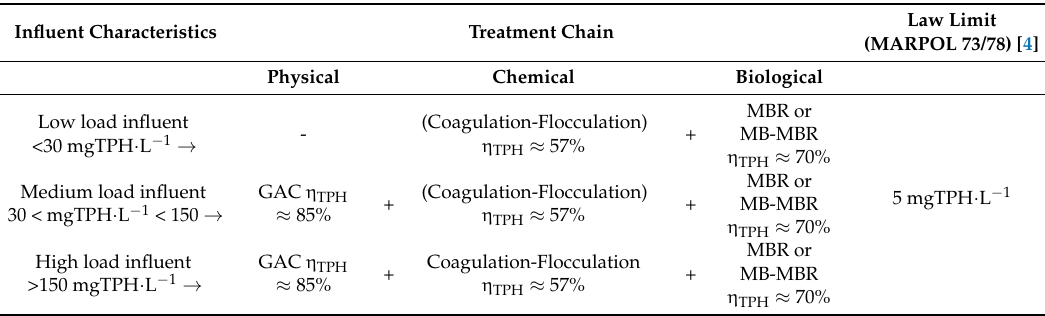
Table 2. Treatment chain proposal depending on the influent concentration of TPH (in parentheses, suggested proposals are